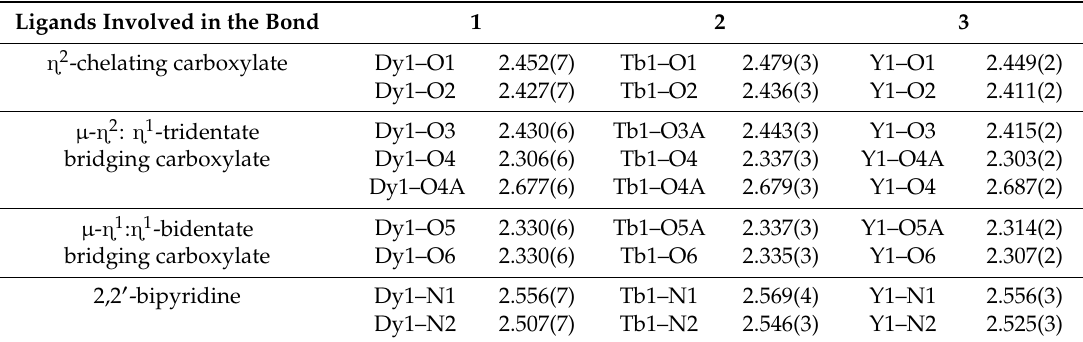
Table 1. Selected bond lengths in Å for Dy III , Tb III and Y III center(s) in 1, 2 and 3, respectively.